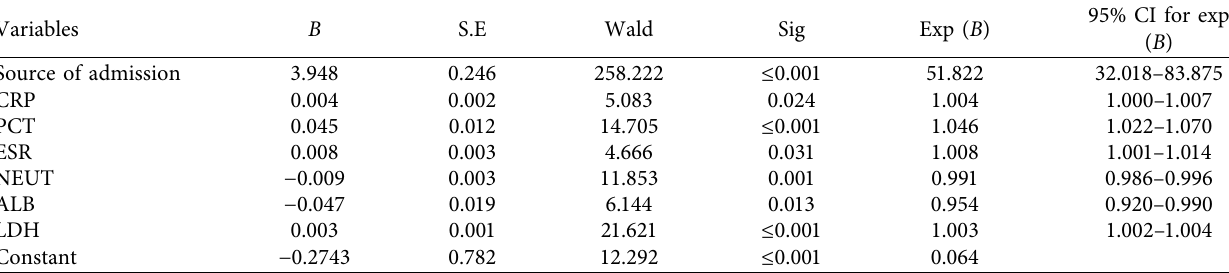
Figure 4: Normalized importance distribution of the infuence of input layer independent variables on the output layer in a concurrent ARDS prediction model for CAP patients based on an artifcial neural network model. Note. CAP, community-acquired pneumonia; ARDS, acute respiratory distress syndrome. Table 3: Multivariate analysis of factors related to ARDS in CAP patients.